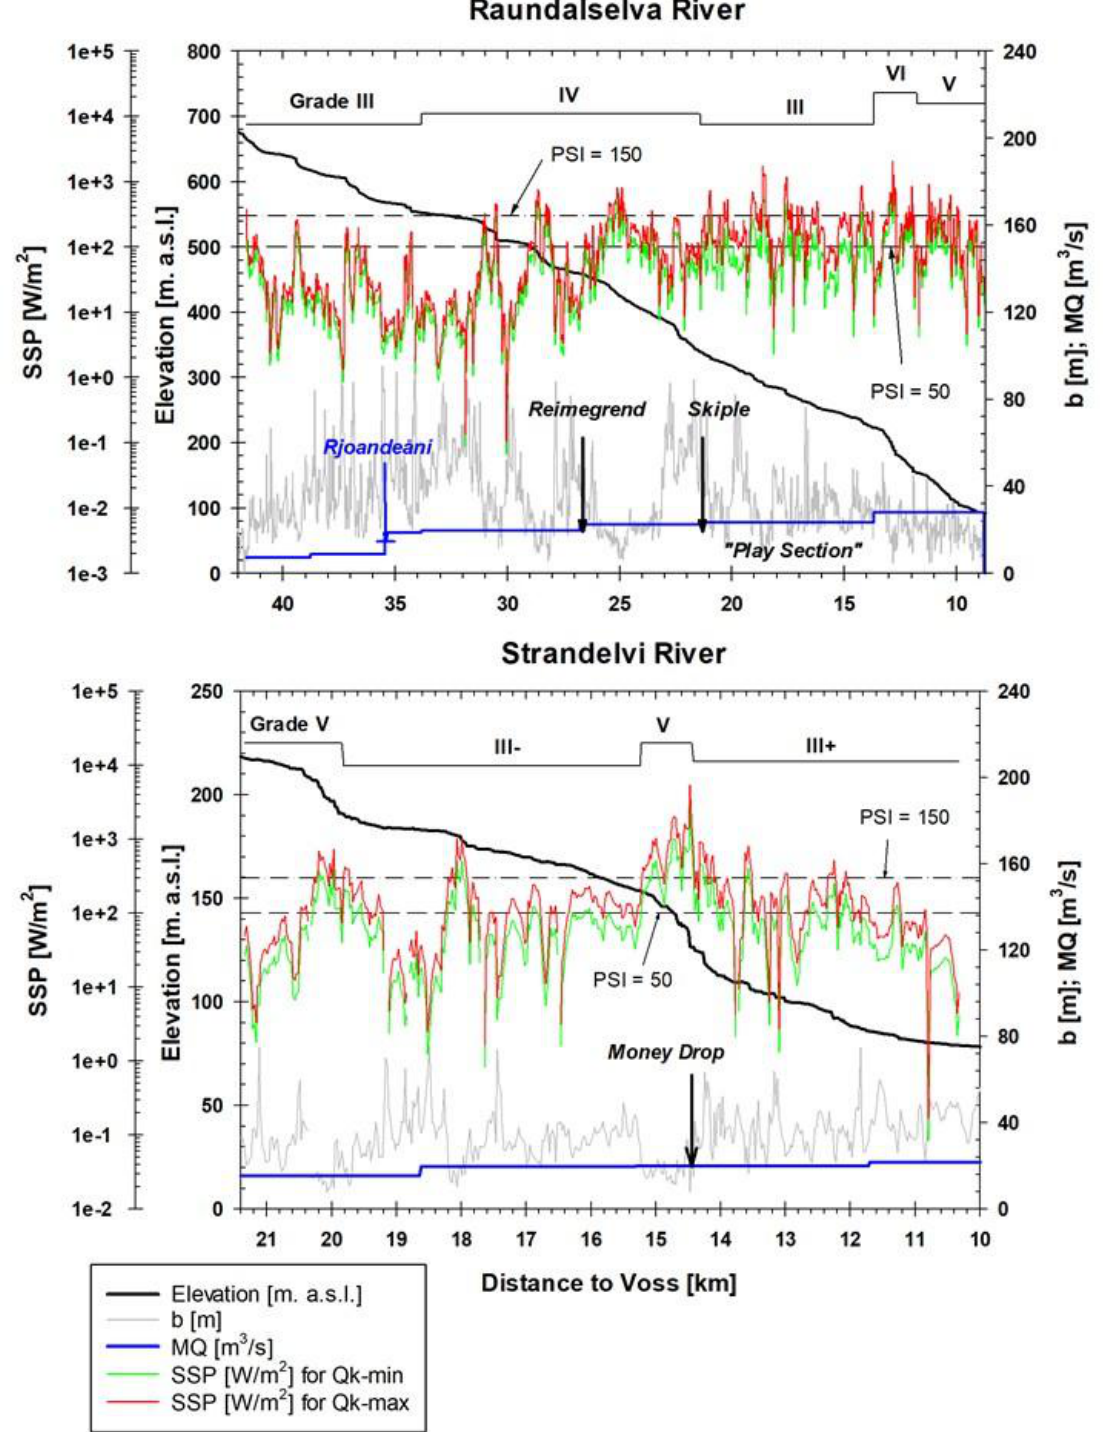
Figure 14. Longitudinal section of the known kayaking reaches at Raundalselva River ( top ) and Strandelvi River ( bottom ), including mean discharge, grade, and SSP. Strandelvi River ( bottom ), including mean discharge, grade, and